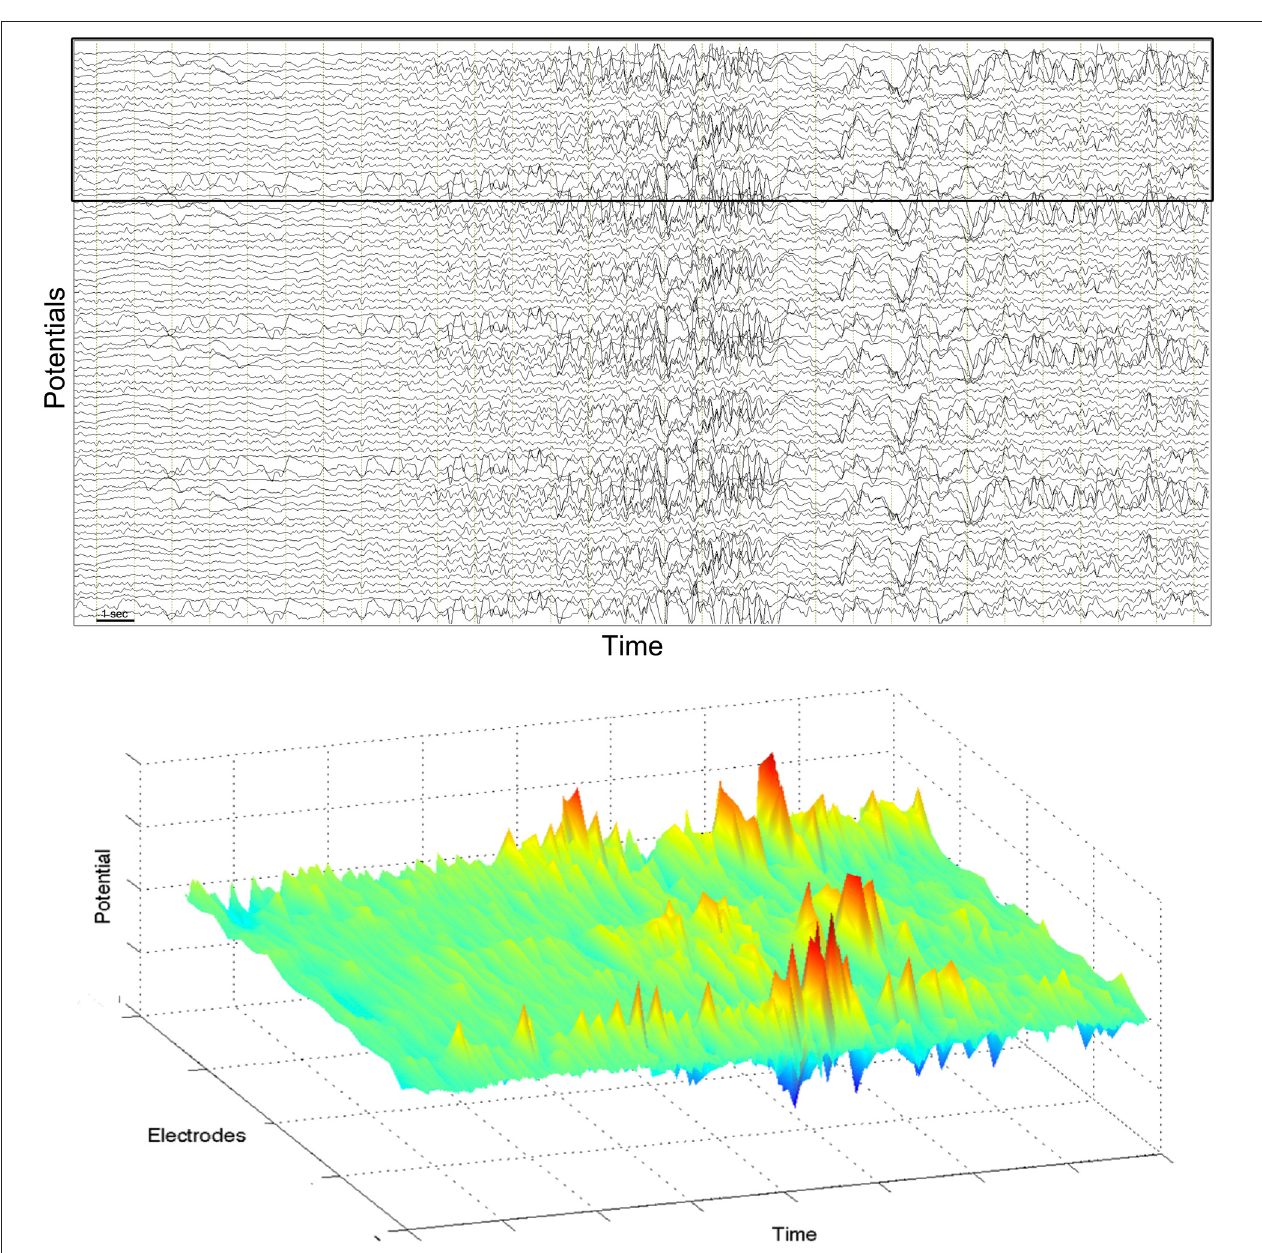
FIGURE 2 | Electrocorticogram of a partial seizure in an adult patient. Top: potentials from 78 grid electrodes are plotted against time. Horizontal axis spans about 30s. Bottom: pseudo-3D plot of 20 electrodes indicated by black frame in the top figure.